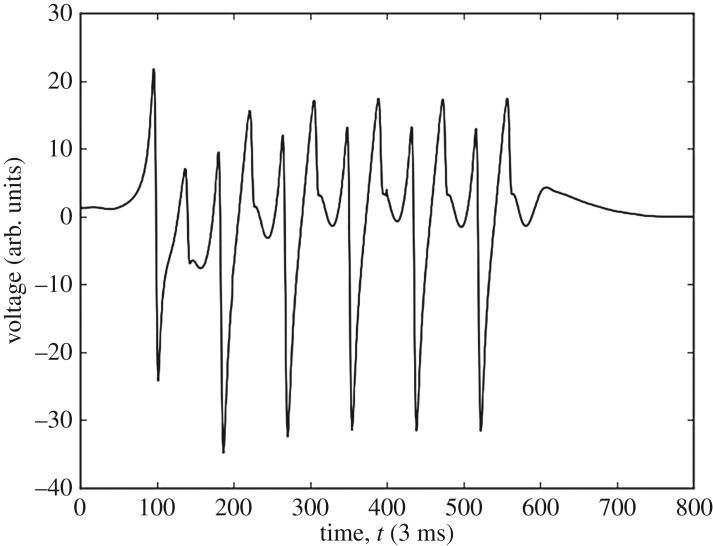
An example of an electrogram showing a short period of fibrillation driven by a re-entrant circuit. The electrogram has been recorded on the point of re-entry. More details can be found in [15].